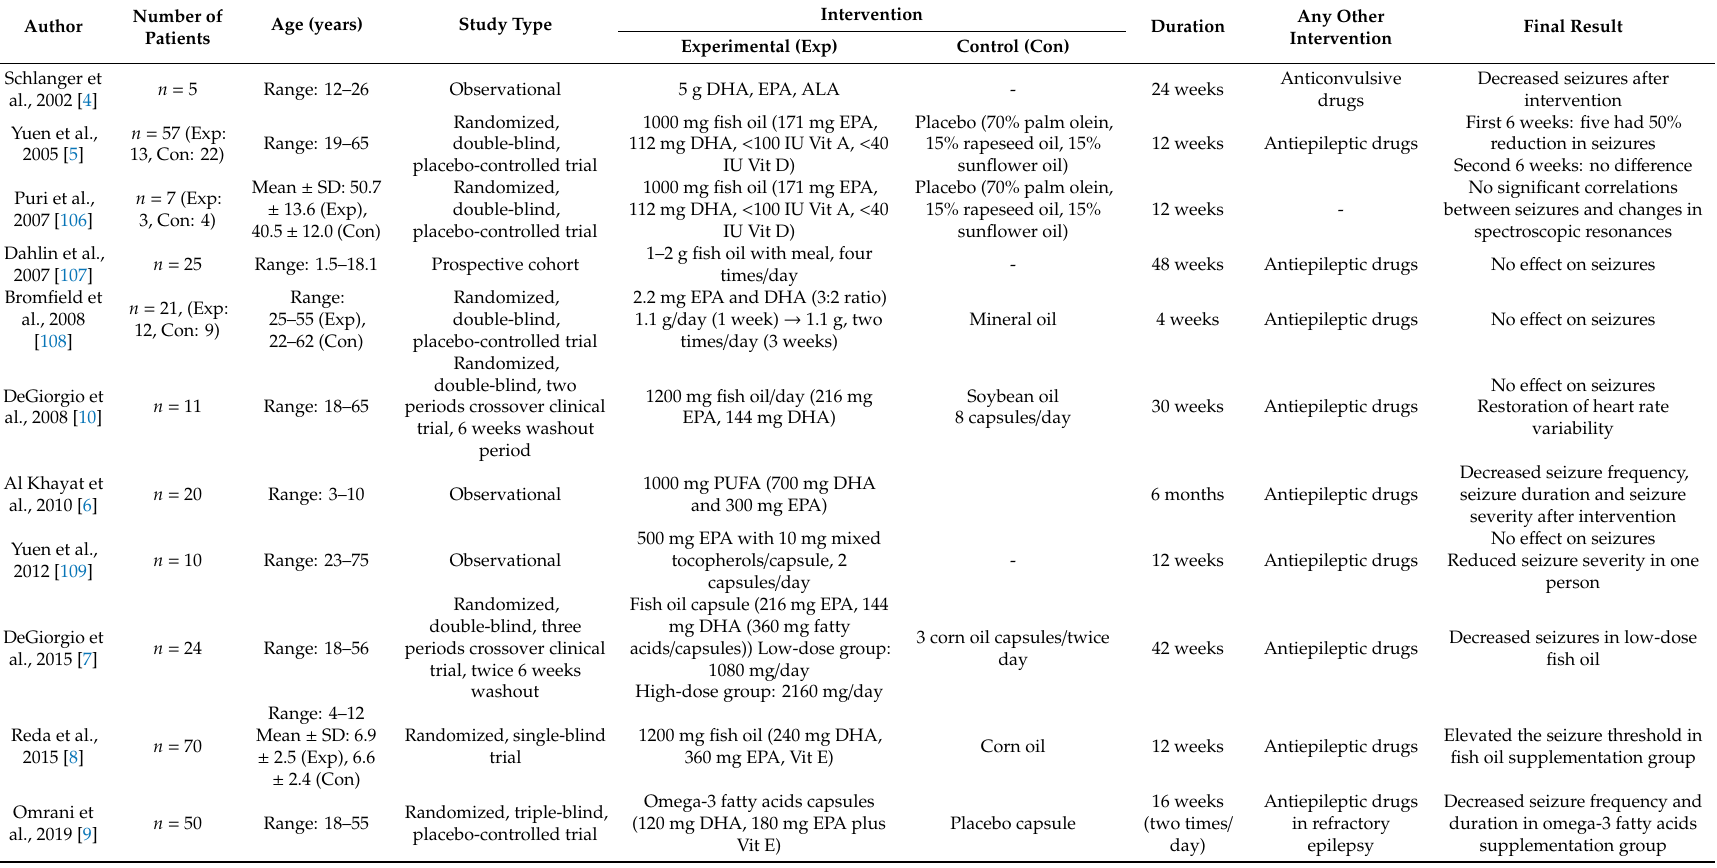
Table 1. Clinical studies assessing the e ffi cacy of fish oil in patients with